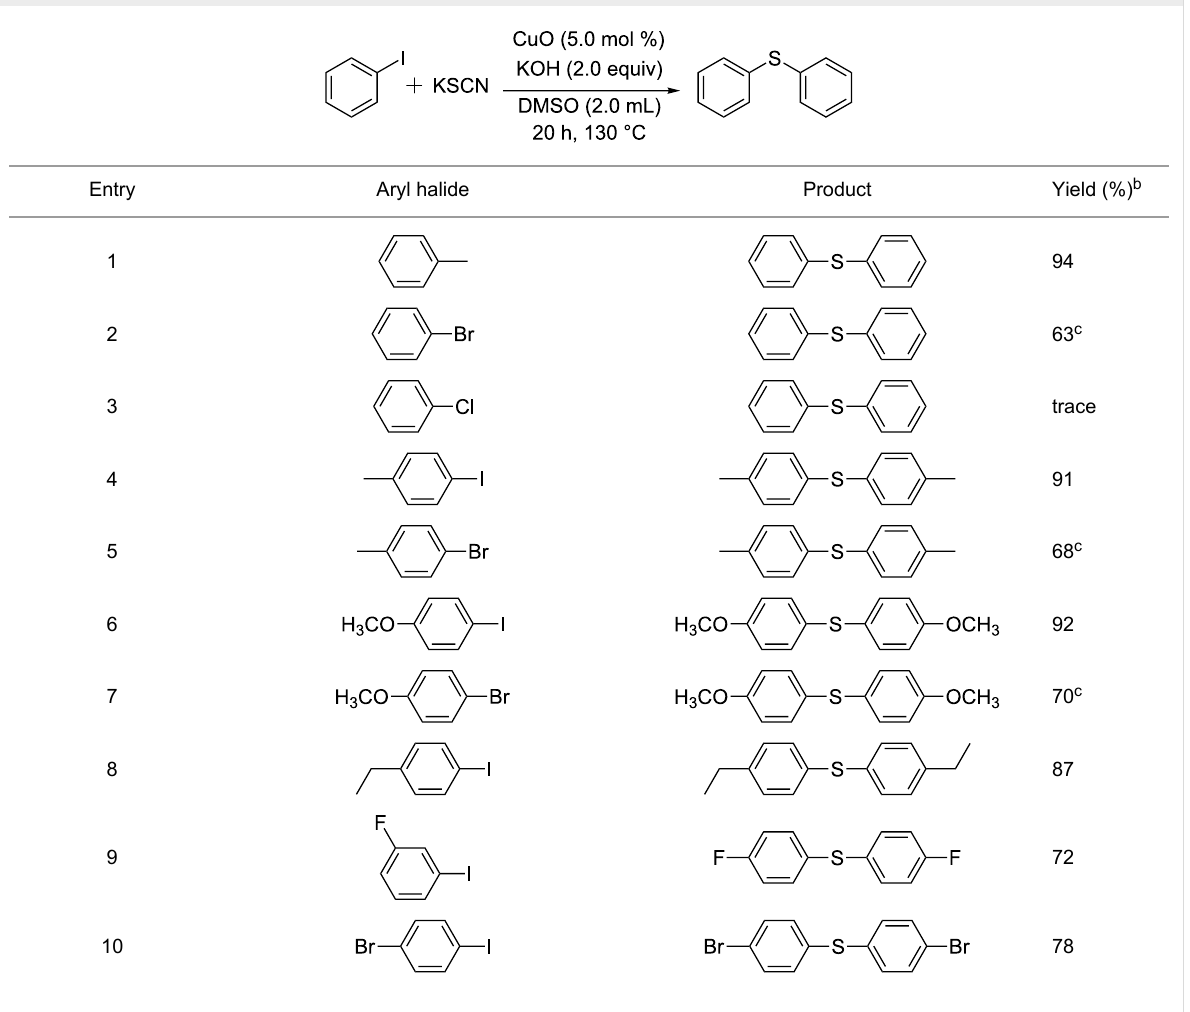
Table 3: Copper oxide nanoparticles catalyzed synthesis of diaryl sulfides a .